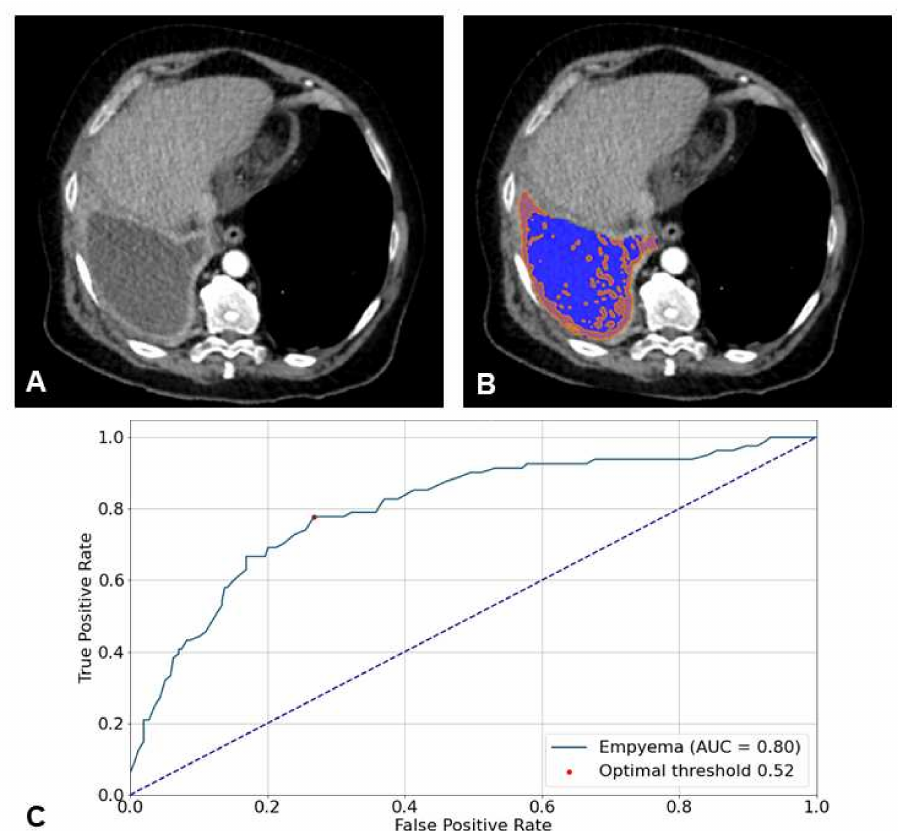
Figure 5. ( A ). Biphasic axial CT with pathologically proven empyema on the right side with pleural thickening and enhancement. ( B ). nnU-net based 3D segmentation (blue), within the mask density values > 15 HU are colored orange. ( C ). ROC analysis of the random forest model based on radiomics features to predict empyema. The optimal threshold is based on Youden’s